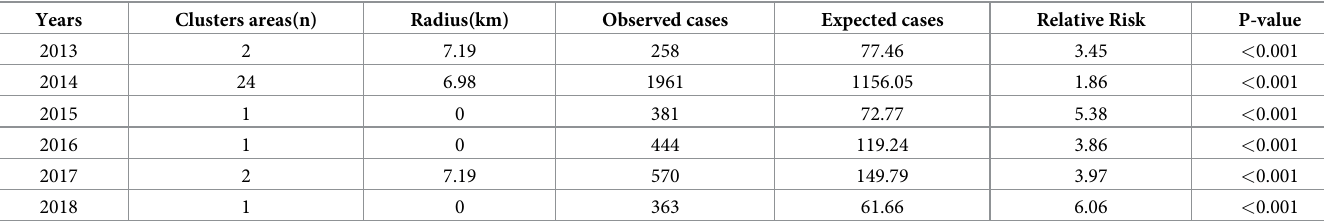
Table 3. The most likely high risk clusters of HFMD cases detected using the purely spatial analysis.